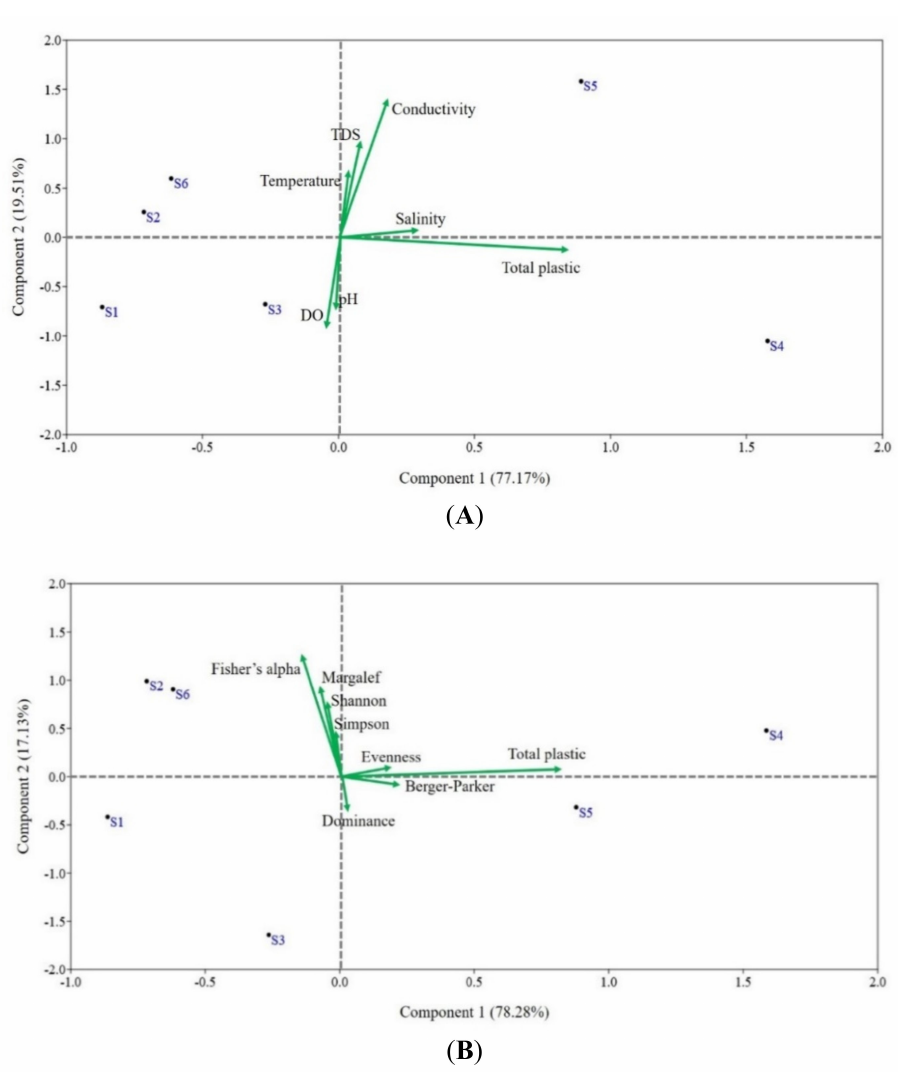
Figure 7. Principal component analysis (PCA). ( A ) Total plastics with water parameters, and ( B ) total plastics with fish diversity